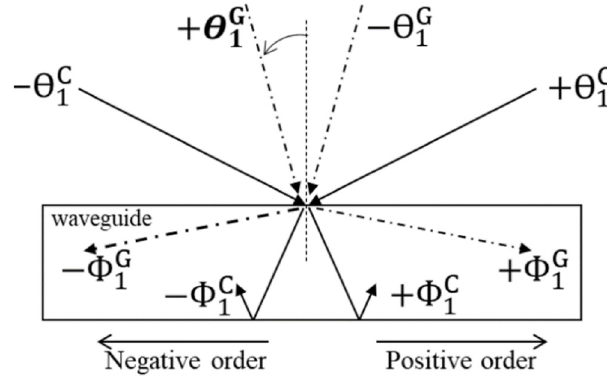
Fig. 1. Schematic of dual-mode diffraction grating design with overlap of